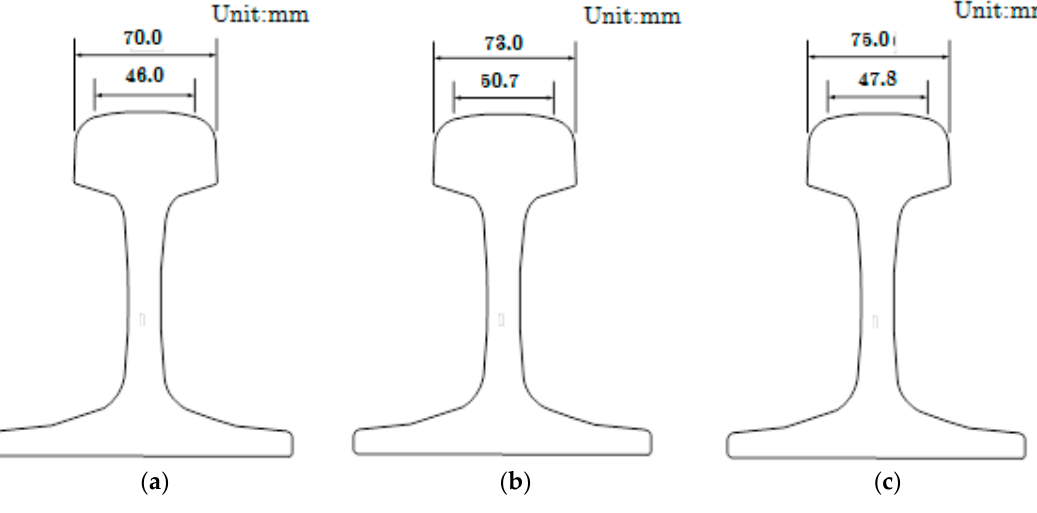
Figure 8. Dimensions of the rail tread. ( a ) 50 kg/m; ( b ) 60 kg/m; ( c ) 75 kg/m.